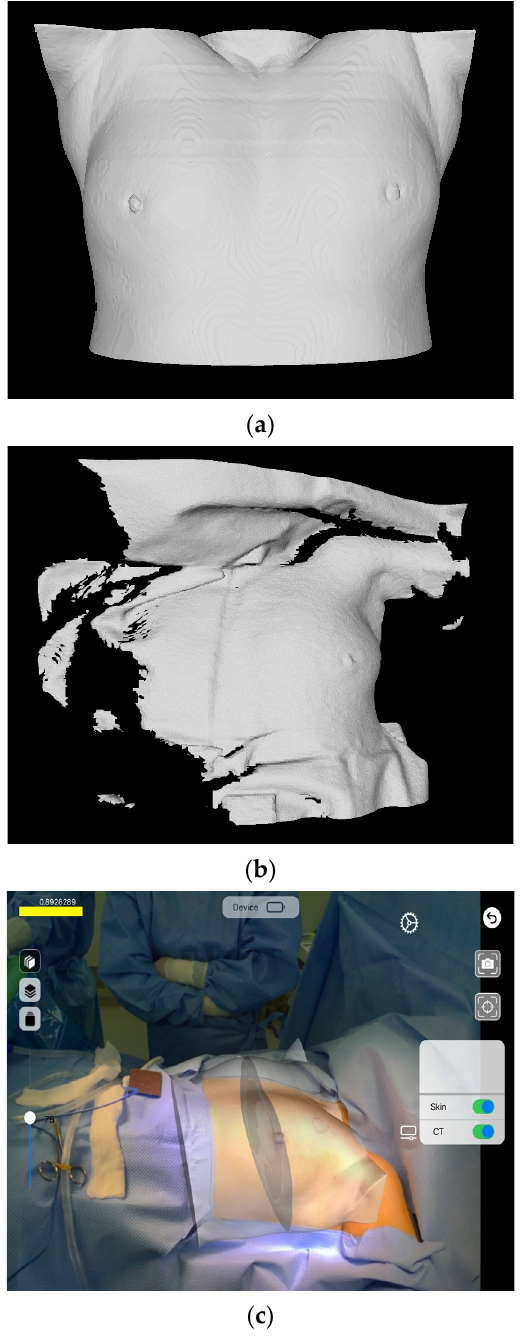
Figure 5. Results of patients’ data registration and AR visualization. ( a ) Skin mesh. ( b ) 3D scan result. ( c ) AR visualization of registration